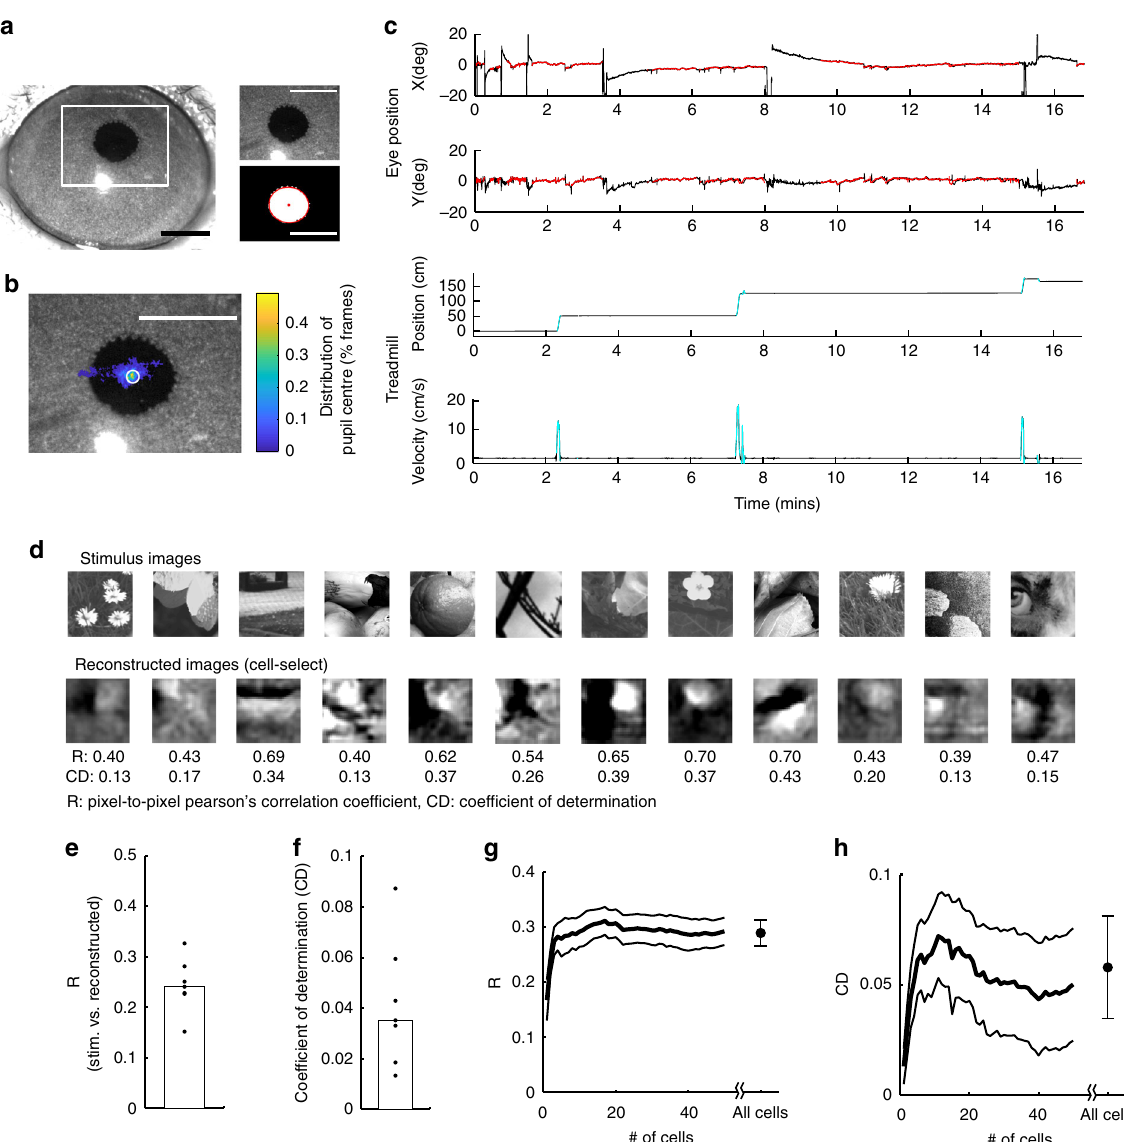
Fig. 8 Image representation in awake mice. a , b Schematic of eye position analysis. a Image of a right eye. The white rectangle indicates the area recorded during imaging and analyzed of fl ine (left). The recorded image (upper right panel) was binarized, and the pupil was fi tted with an ellipse (red contour in lower right panel). The center of the ellipse was used to estimate the eye position (red dot). b Distribution map of eye position during imaging overlaid onto the image in a . The peak position of the distribution was detected, and the data were used for subsequent analyses only when the eye stayed around the peak position (white circle, <3.5 degrees or ~70 microns on the image). Scale bars: 1 mm. c Examples of eye position and locomotion state during imaging. Upper two panels: horizontal ( X ) and vertical ( Y ) eye positions. The red lines indicate time points at which the eye stayed around the peak position (inside the white circle in b ). Lower two panels: position and velocity of a disc-type treadmill. The cyan lines indicate time points at which the mouse ran (velocity >2 cm/sec). d – h Image reconstruction by the cell-selection model in awake mice. d Examples of the reconstructed images. e , f Reconstruction performances ( e pixel-to-pixel correlation, R. f coef fi cient of determination, CD); N = 7 planes. g , h R g and CD h versus the number of neurons. A single image was reconstructed by a small number of neurons. The thick black line and gray lines indicate the means and the means ± S.E.M, respectively ( n = 6 planes). Only data for images that included at least fi ve responsive cells were used. The stimulus images in d are adapted from the databases in refs. 56,57 with permission. Source data are provided as a Source Data fi edu/Image_Datasets/Caltech101/) 58 , a free image website (https://www.pakutaso. image fl ashes to reduce the total recording time and maximize the number of repetitions. In this design, the tail of the Ca 2 + response to one image invaded the com/), and images that we photographed. In experiments using these image sets, each image was presented three to eight times. time window of the next image presentation (Fig. 1b). Although this overlap may Moving square gratings (eight directions, 0.04 cycles/degree, 2Hz temporal have affected the visual responses to two adjacent images, the use of many trial frequency, 60-degree patch diameter) were presented at the same position as the repetitions with the pseudorandom image sequences and the sparse responses to natural image on the screen. Each direction was presented for 4s interleaved by 4s natural images (Fig. 1) minimized the effects of response contamination between of the gray screen. The sequence of directions was pseudo-randomized, and each two consecutive images. direction was presented ten times for anesthetized mice. In another set of experiments with anesthetized mice, we used different image All stimuli were presented with PsychoPy 59 on a 32-inch, gamma-corrected sets (1000 – 2000 images that did not contain the 200 images described above, n = 4 planes from three mice). The original images for these sets were derived from the liquid crystal display monitor (Samsung, Hwaseong, South Korea) with a 60-Hz image datasets described above, the Caltech 101 dataset (http://www.vision.caltech. refresh rate, and the timing of the stimulus presentation was synchronized with the